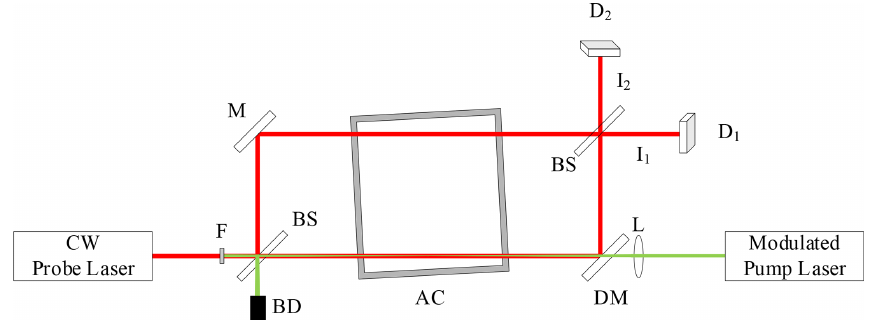
Figure 2. A potential realisation of a standard two-beam photothermal interferometer, similar to published configurations (see, e.g., Lee and Moosmüller, 2020). The pump laser is set to overlap the probe beam in the measurement arm of the interferometer within the aerosol chamber. Note: BS – beam splitter; M – mirror; DM – dichroic mirror; F – bandpass filter; BD – beam dump; AC – aerosol chamber; D – detector.